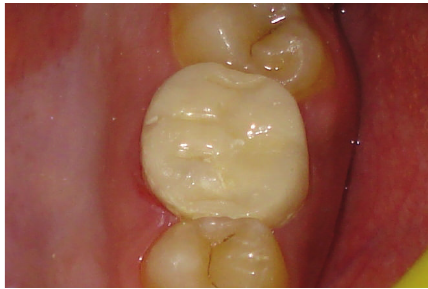
Figure 5: Provisional crown cemented with zinc phosphate cement.